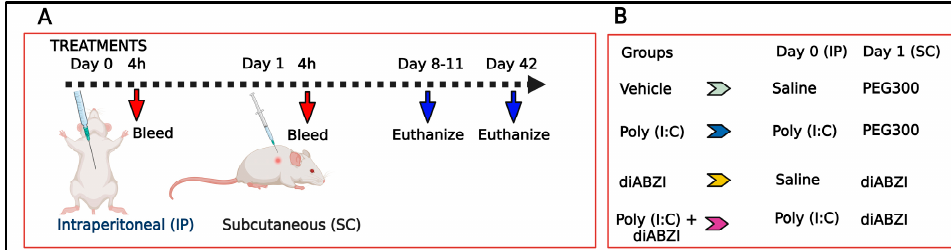
Figure 1. ( A ) Experimental design. Female BALB/cJ mice were given poly (I:C) or saline intraperi- toneally on day 0 and diABZI or 40% PEG300 subcutaneously on day 1. Tail bleeds were collected 4 h after each injection for cytokine analysis. The subcutaneous injection site was monitored for skin inflammation for up to 6 weeks. Mice were euthanized at different time points, and skin from the injection site was studied by histopathology, immunostaining, and inflammatory gene expression. ( B ) Four different experimental groups were studied.